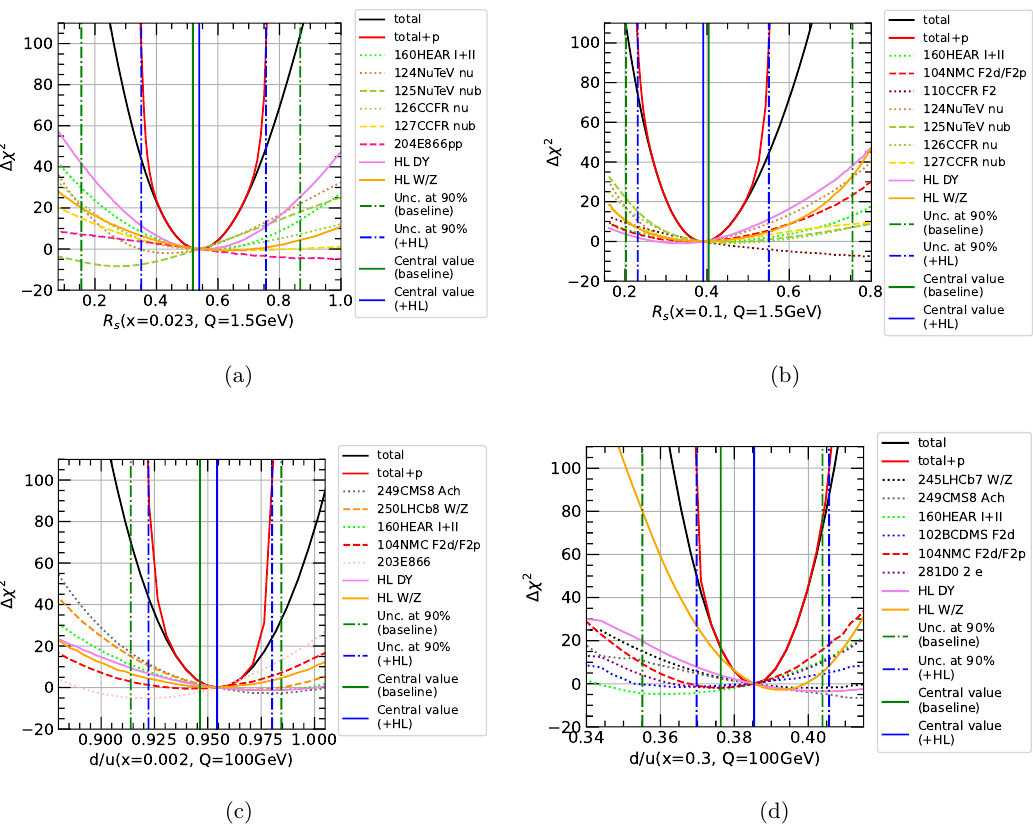
Figure 20 . LM scans on the R s at Q = 1 . 5 GeV and x = 0 . 023 or 0.1 (upper panels), and LM scans on the d/u at Q = 100 GeV and x = 0 . 002 or 0.3 (lower panels). The blue and the green vertical solid (dot-dash) lines represent the central values (uncertainties) with and without HL-LHC pseudo-data